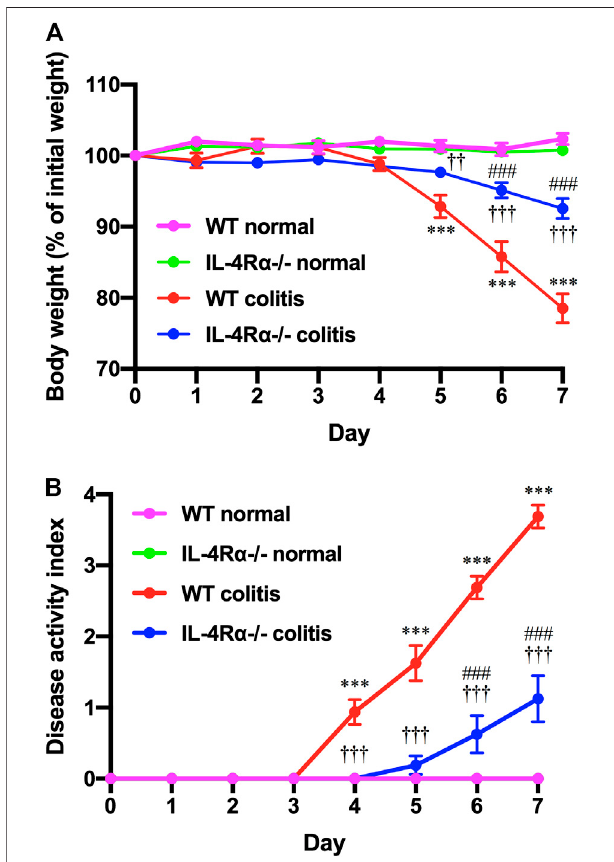
FIGURE 1 | IL-4R α -/- mice exhibit reduced susceptibility to DSS- induced colitis. Colitis was induced in WT and IL-4R α -/- mice by daily treatment with a 3% DSS solution in the drinking water for seven days. (A) Body weight and (B) disease activity index are shown. The data are presented as the mean ± SEM values for eight mice and are representative of one of three independent experiments. *** p < 0.001 compared with WT normal mice. †† p < 0.01 and ††† p < 0.001 compared with WT colitis mice. ### p < 0.001 compared with IL-4R α -/- normal